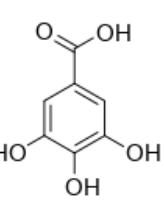
Figure 1. Chemical structure of gallic